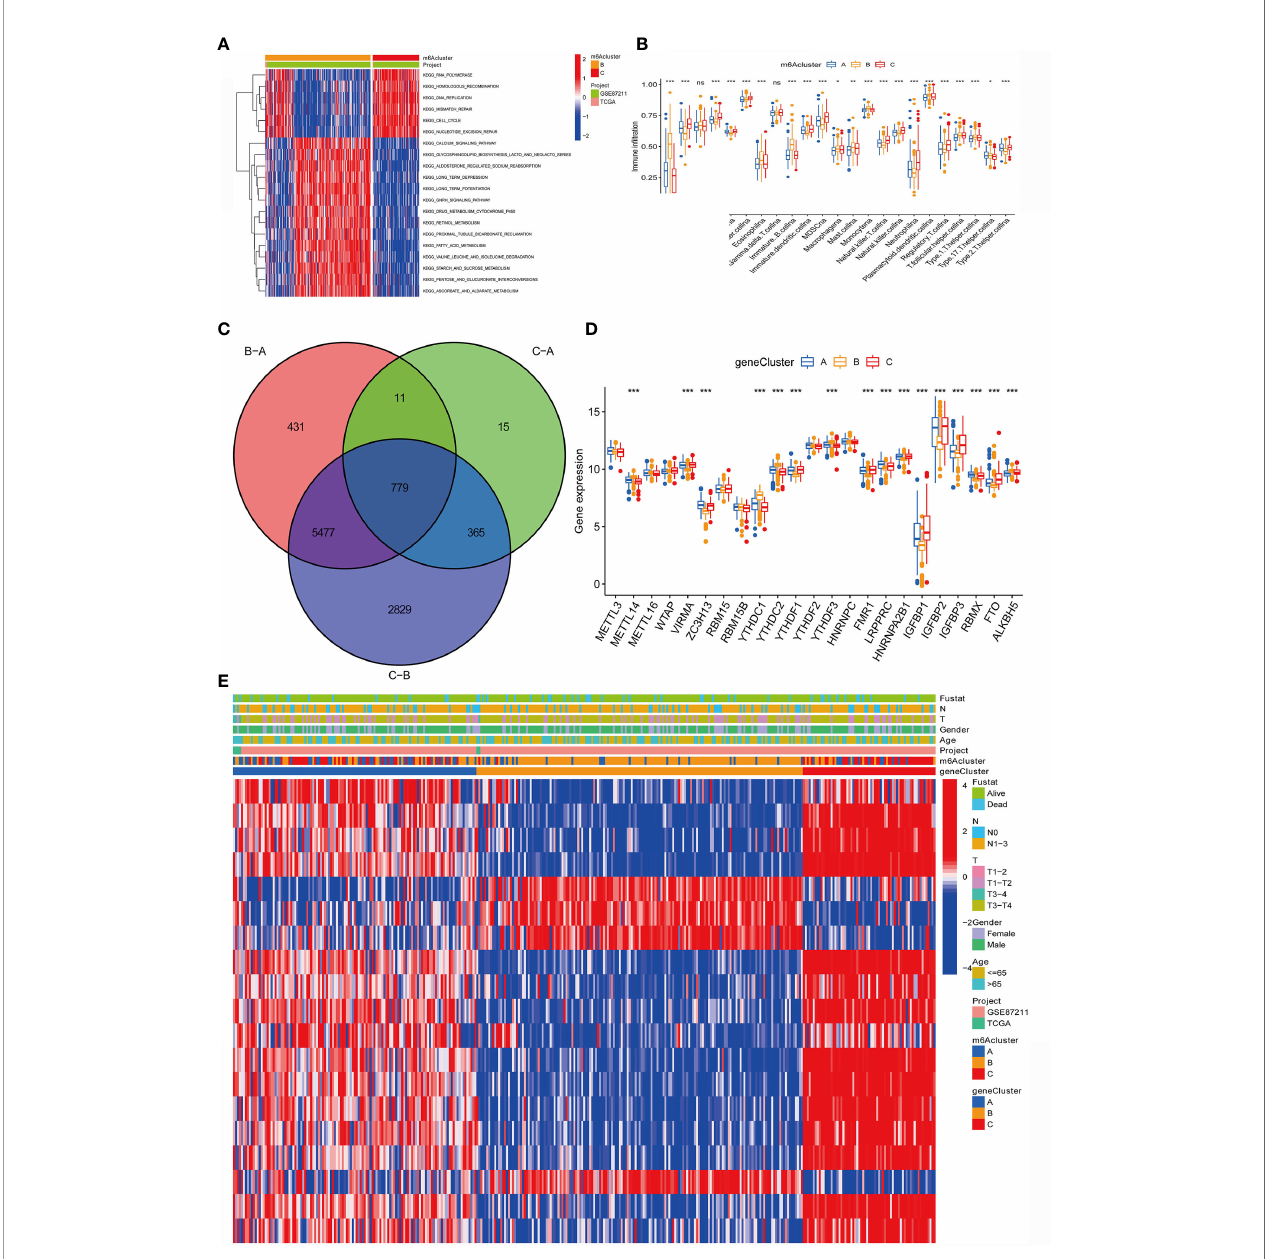
FIGURE 4 | Construction of m 6 A differential gene expression and gene cluster. (A) The heat maps show the differences in KEGG enrichment analysis results between the m 6 Acluster B and m 6 Acluster C. (B) The abundance of each TME in fi ltrated cell in the three m6A modi fi cation modes. The upper and lower ends of the box represent a quarter of the value range. The line in the box represents the median value, and the dots outside the boxes and their vertical lines represent the outliers. The ordinate shows the immune in fi ltration while the abscissa represents various types of immune cells. Asterisks indicate statistical P values (*P < 0.05; **P < 0.01; ***P < 0.001). "ns" means "no signi fi cance". (C) 779 m 6 A-related differentially expressed genes (DEGs) are displayed in the intersection of Venn diagram among the three m 6 A clusters. The red circle represents the DEGs between patients of m6A cluster B and cluster A. The green circle represents the DEGs between patients of m6A cluster C and cluster A. The purple circle represents the DEGs between patients of m6A cluster B and cluster C. (D) Expression of 23 m 6 A regulatory factors in three gene clusters. The upper and lower ends of the box represent a quarter of the value range. The line in the box represents the median value, and the black dots represent the outliers. The ordinate represents the level of gene expression in a gene cluster while the abscissa represents the 23 m6A regulatory factors. Asterisks indicate statistical P values (*P < 0.05; **P < 0.01; ***P < 0.001). One-way ANOVA was used to test the statistical differences among the three gene clusters. (E) Unsupervised aggregation in the GSE87211 rectal cancer cohort, using survival status, tumor stage, gender, age, project, m 6 Acluster, and gene cluster as patient annotations. Red represents high expression of regulatory factors, and blue represents low